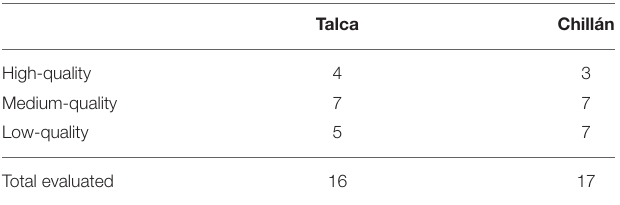
TABLE 4 | Number of parks and squares in Talca and Chillán by quality level, taken from the results of question A of the perception survey. Talca